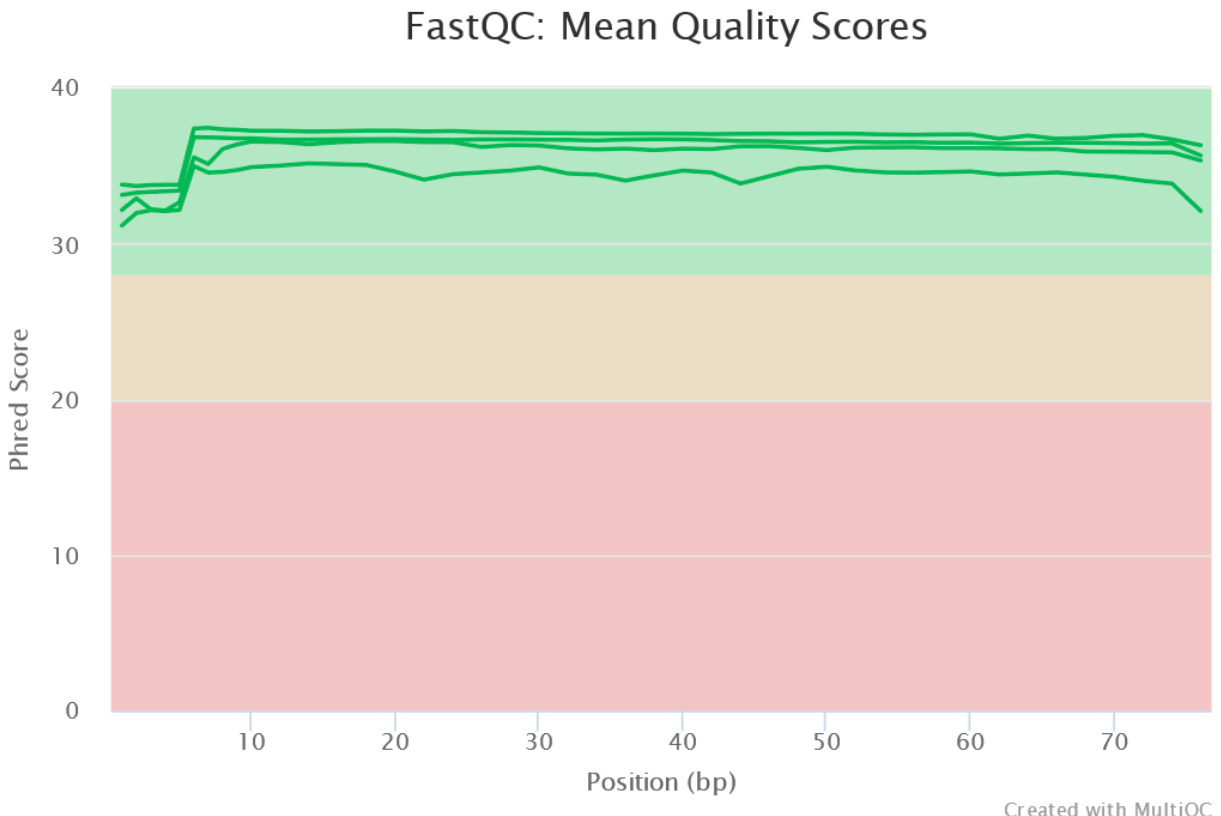
Figure 3. Read quality control showing high-quality sequences.